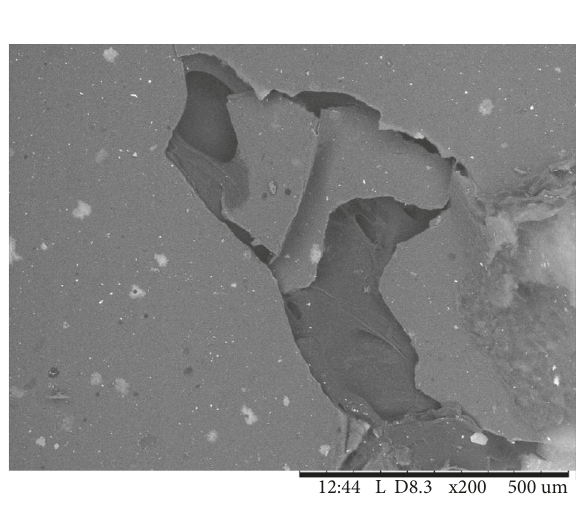
Figure 13: SEM image of graphene with stratified layers from 5 LightScribe reduction cycle